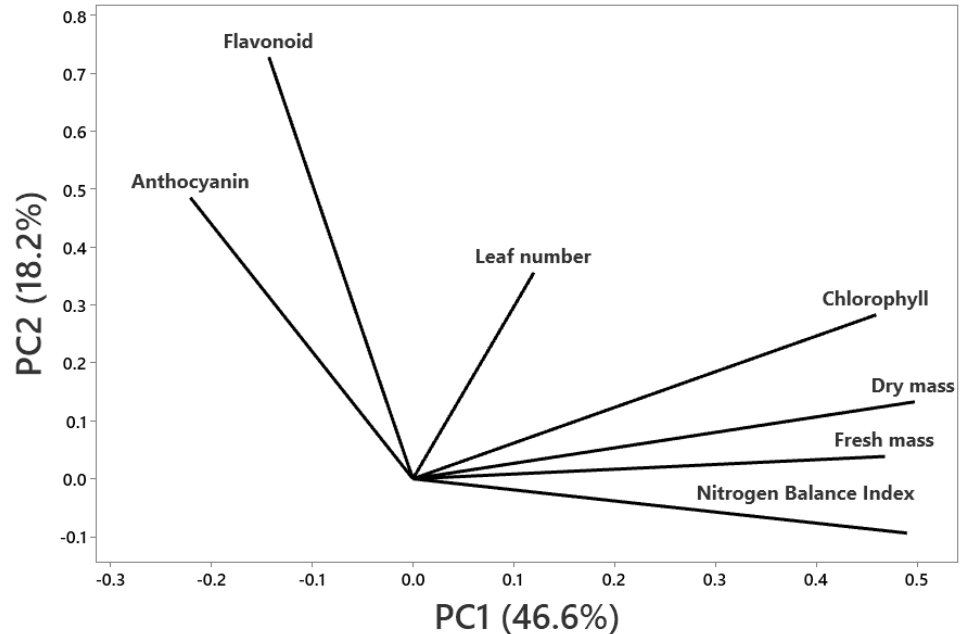
Figure 2. Loading plot in principal component analysis (PCA) of first two principal components (PC) scores, PC1 and PC2 describing the classification of different lettuce genotypes into different salt-tolerant groups (high tolerance, moderate tolerance, low tolerance, and highly sensitive) based on seven morpho-physiological parameters measured 42 days after sowing for all the genotypes.